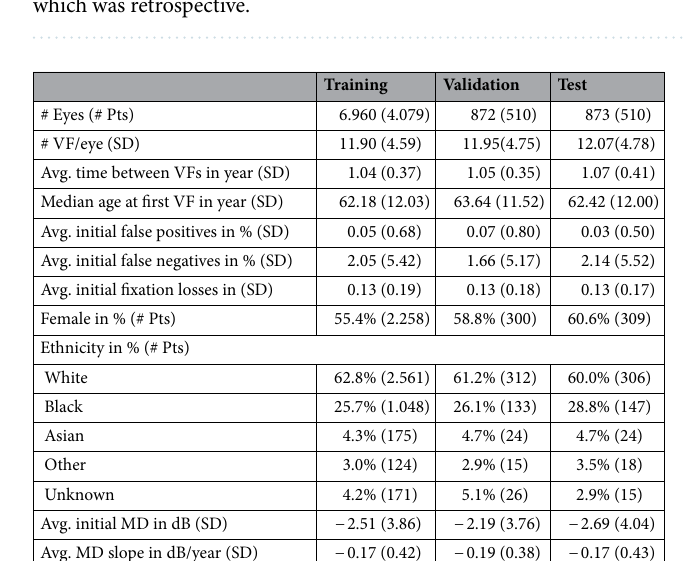
Figure 1. Study inclusion criteria. The flow chart shows the total number of patients, eyes, and VF exams that were present at baseline. Eyes were excluded if they did not have complete VF data and did not have at least 7 reliable fields. The final criterion for inclusion was the clinicians’ decision of worsening at the time of VF testing, which was retrospective.